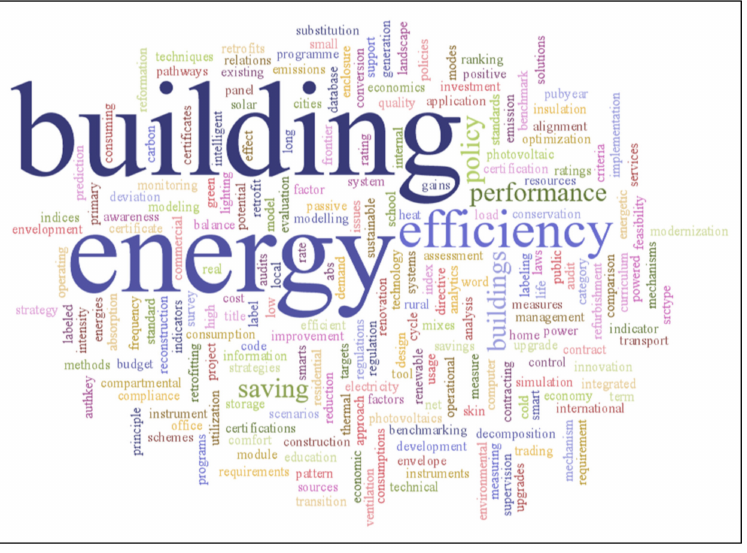
Figure 2. Word Cloud used to build the search terms (source: authors).